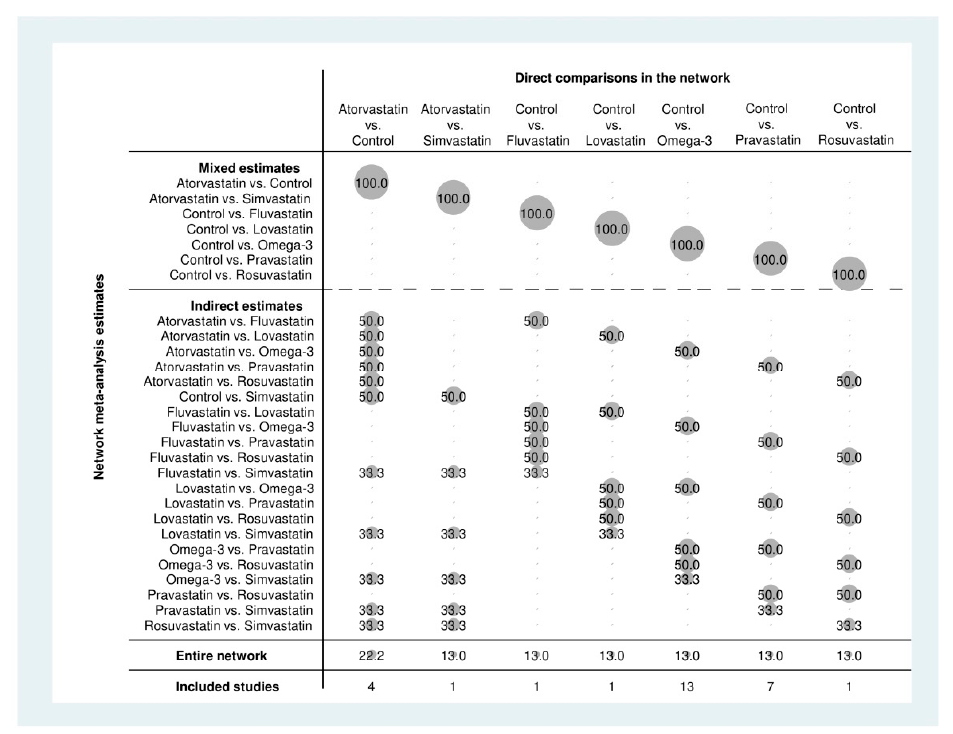
Figure A3. Non-linear association between cardiovascular event reduction and LDL-C lowering effects of omega-3 supplementation. Cardiovascular events include (a) total cardiovascular disease (CVD), (b) coronary heart disease (CHD), (c) myocardial infarction (MI), and (d) stroke. RR, relative risk; LDL-C, low-density lipoprotein cholesterol.